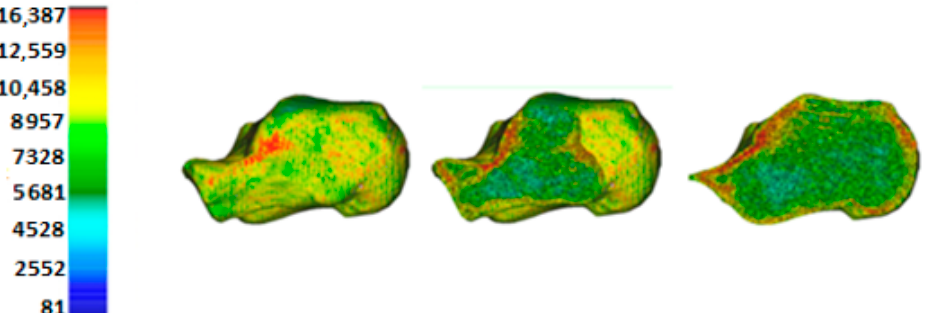
Figure 10. Distribution of the elasticity modulus E /MPa/for the heel bone (100 materials acquired from CT images via Mimics software)–sagittal projection.